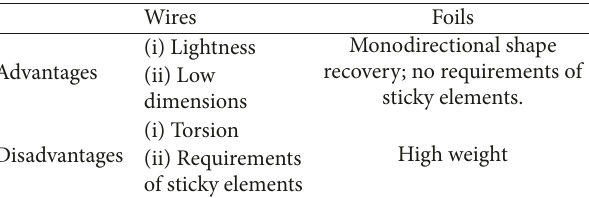
Table 1: Advantages and disadvantages of wires and foils.